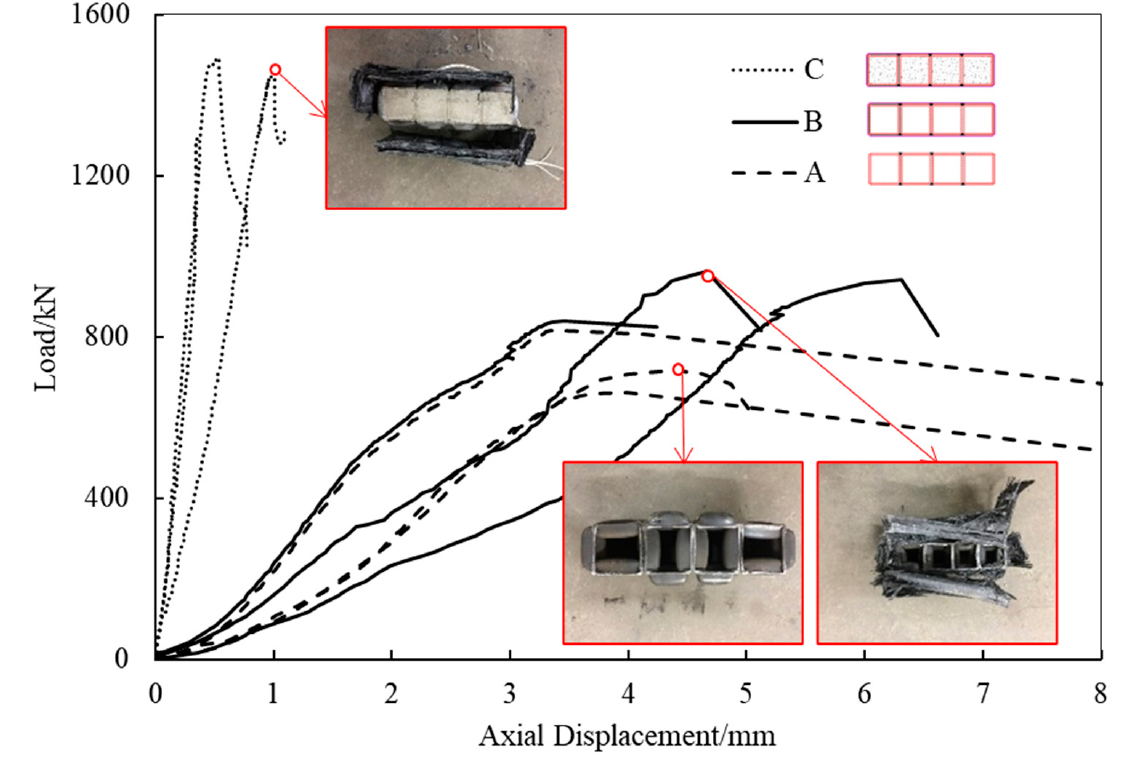
Figure 5. Load–displacement curves of the compression